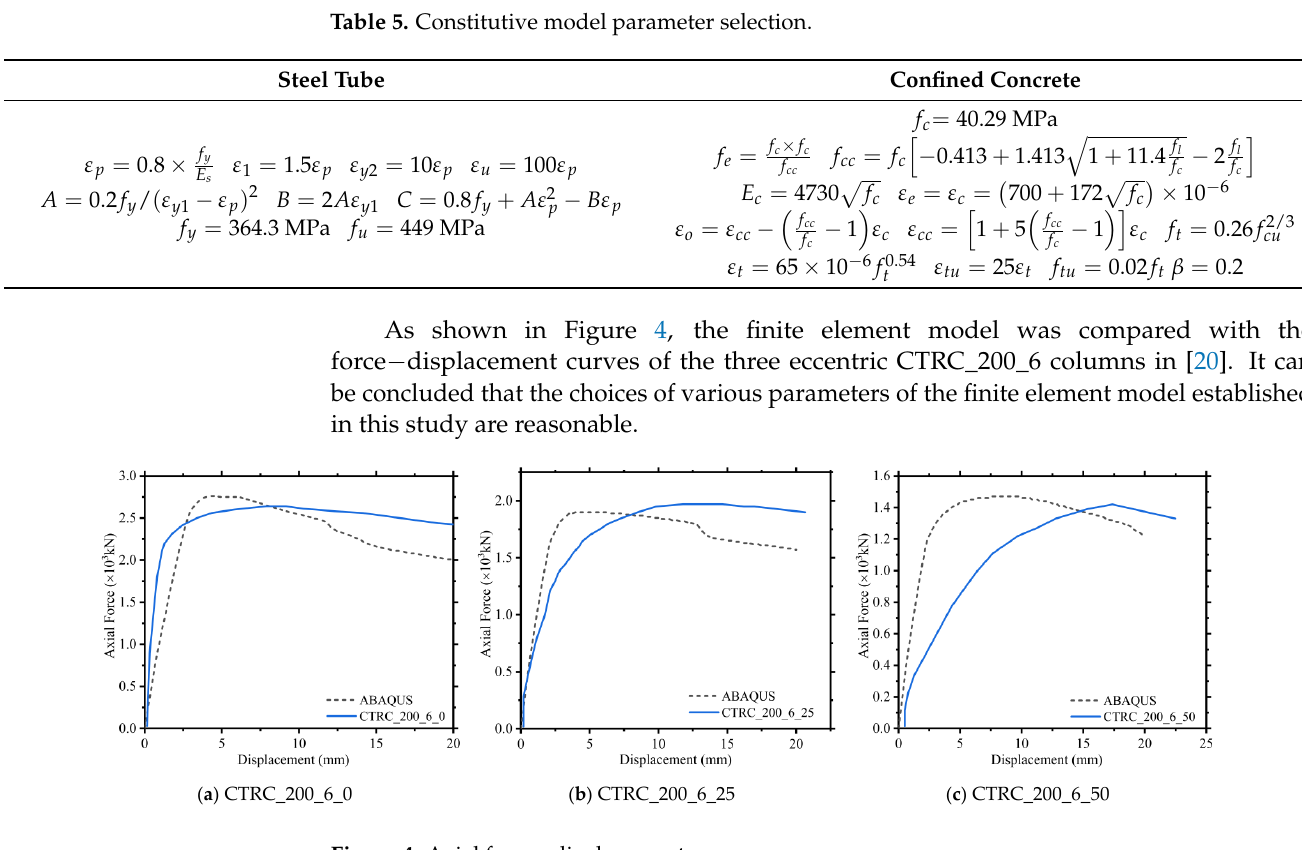
Figure 4. Axial force − displacement